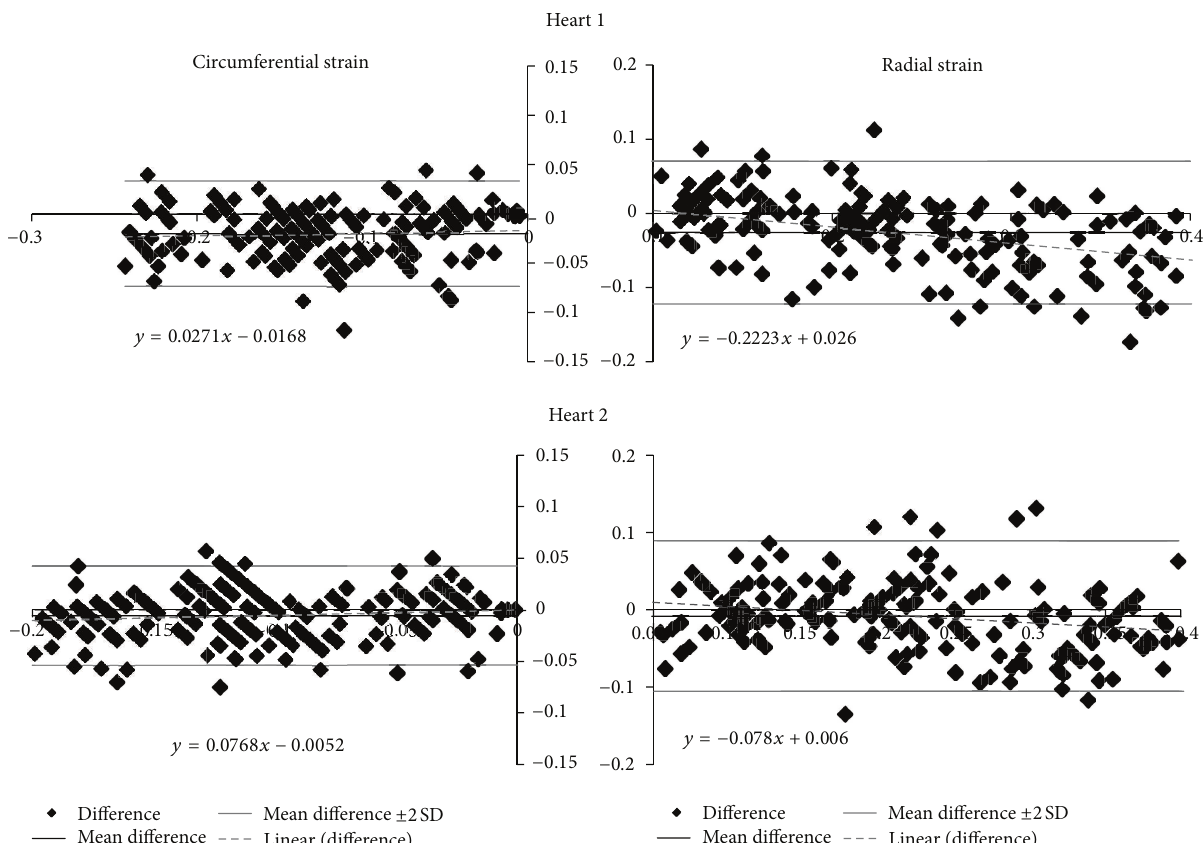
Figure 7: The Bland-Altman analysis comparing the warping strain results with those of the tagged MRI analysis. The warping strain predictions underestimated the strain results compared with the tagged MRI strain predictions. Warping showed little bias in the circumferential direction for both hearts with the linear regression analysis (dashed lines) showing relatively flat slopes in the circumferential strain.